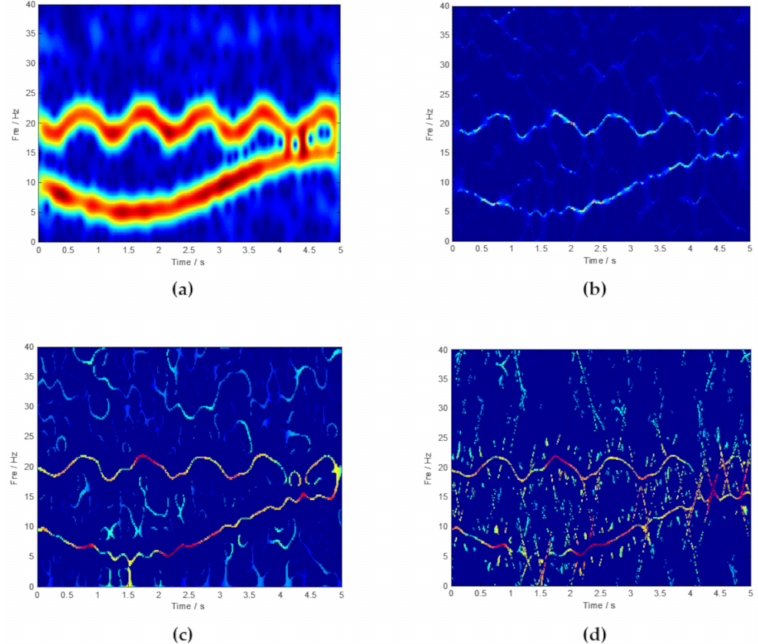
Figure 4. The results of time-frequency (TF) representations provided by ( a ) short-time Fourier transform (STFT), ( b ) synchrosqueezing transformation (SST), ( c ) synchroextracting transform (SET), and ( d ) synchroextracting chirplet transform